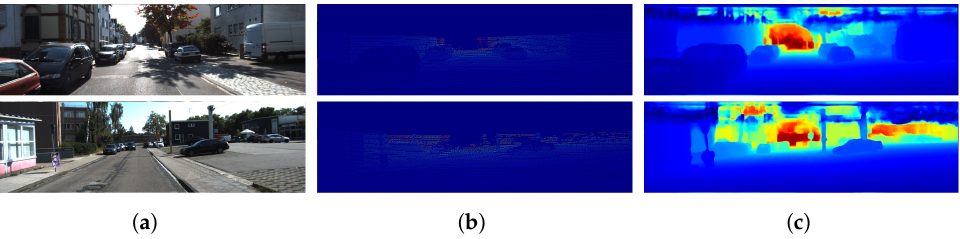
Figure 1. First Column shows the RGB images from two different scenes, the middle column contains the sparse depth maps produced from LiDAR. The last column shows the predicted dense depth maps for the corresponding scenes. ( a ) RGB Image. ( b ) LiDAR sparse Depth Map. ( c )